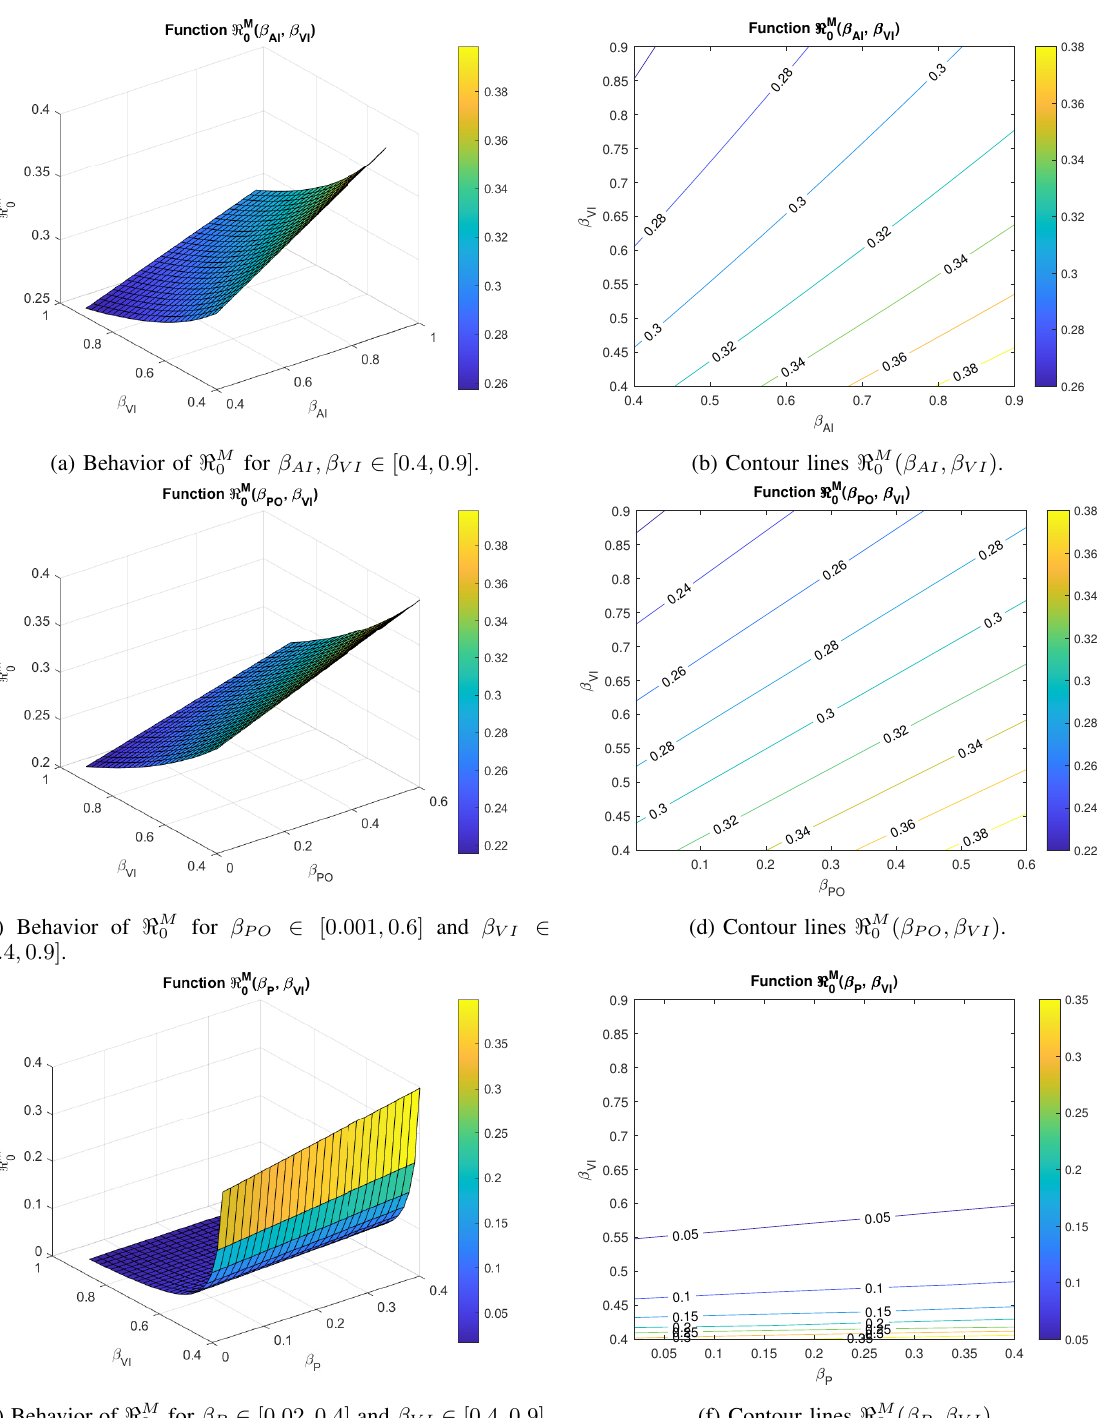
(e) Behavior of (cid:60) M 0 for β P ∈ [0 . 02 , 0 . 4] and β V I ∈ [0 . 4 , 0 . 9] . (f) Contour lines (cid:60) M 0 ( β P , β V I ) . Fig. 7: Graphical behavior for the variation of parameters associated with the use of PrEP, PEP, and undetectability in viral load for HIV and AIDS in the (cid:60) M 0